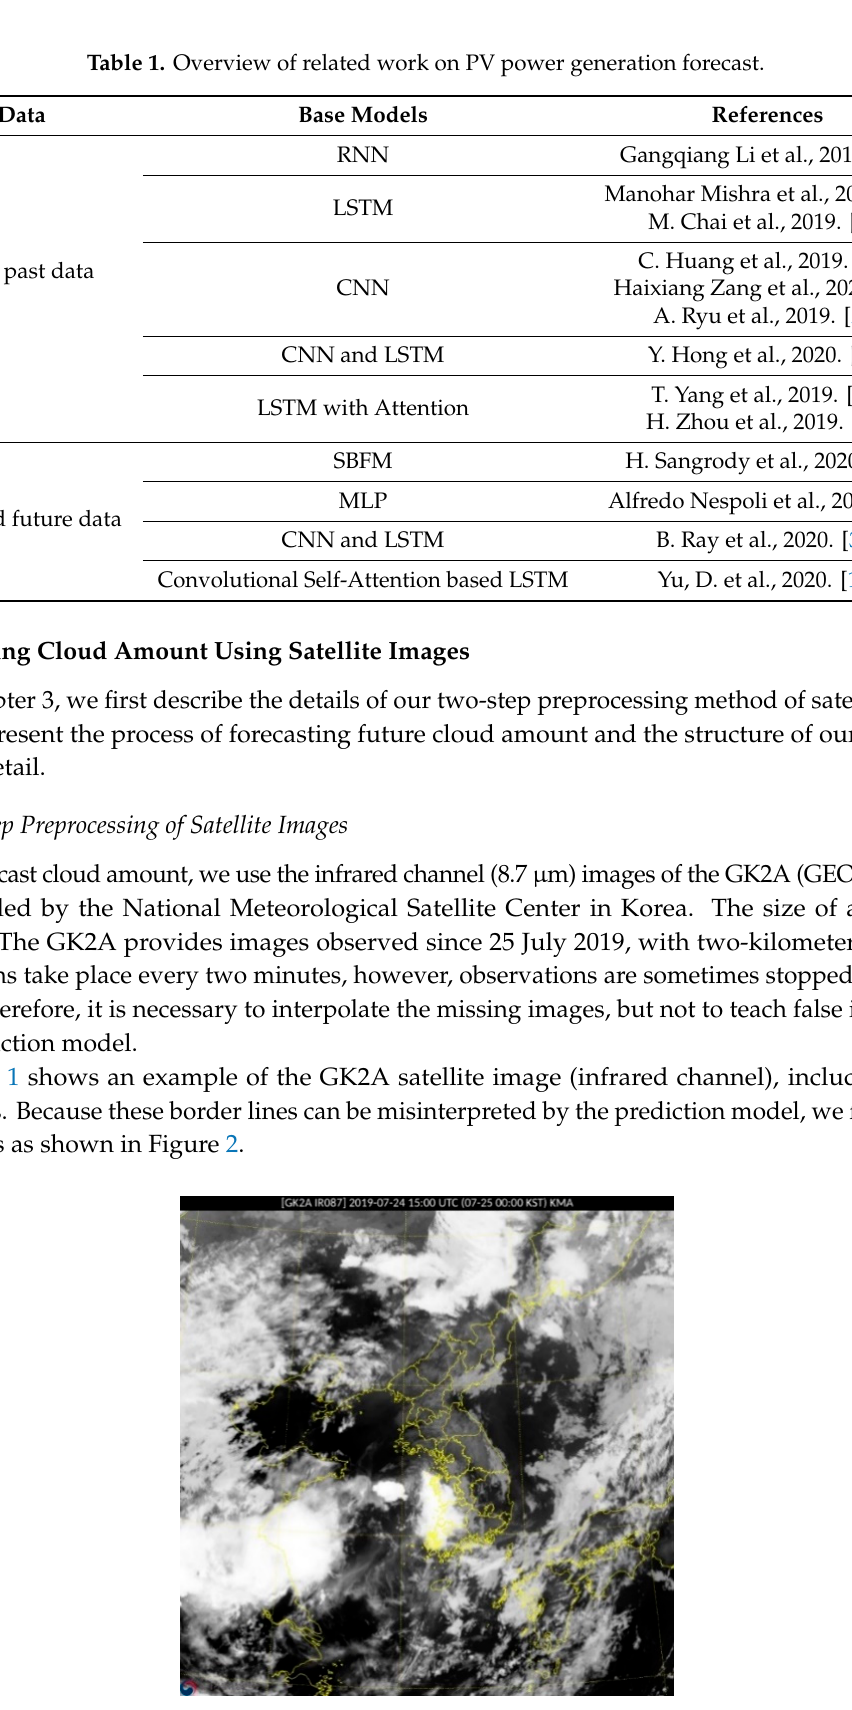
Figure 1. Example of GK2A satellite image (infrared channel).